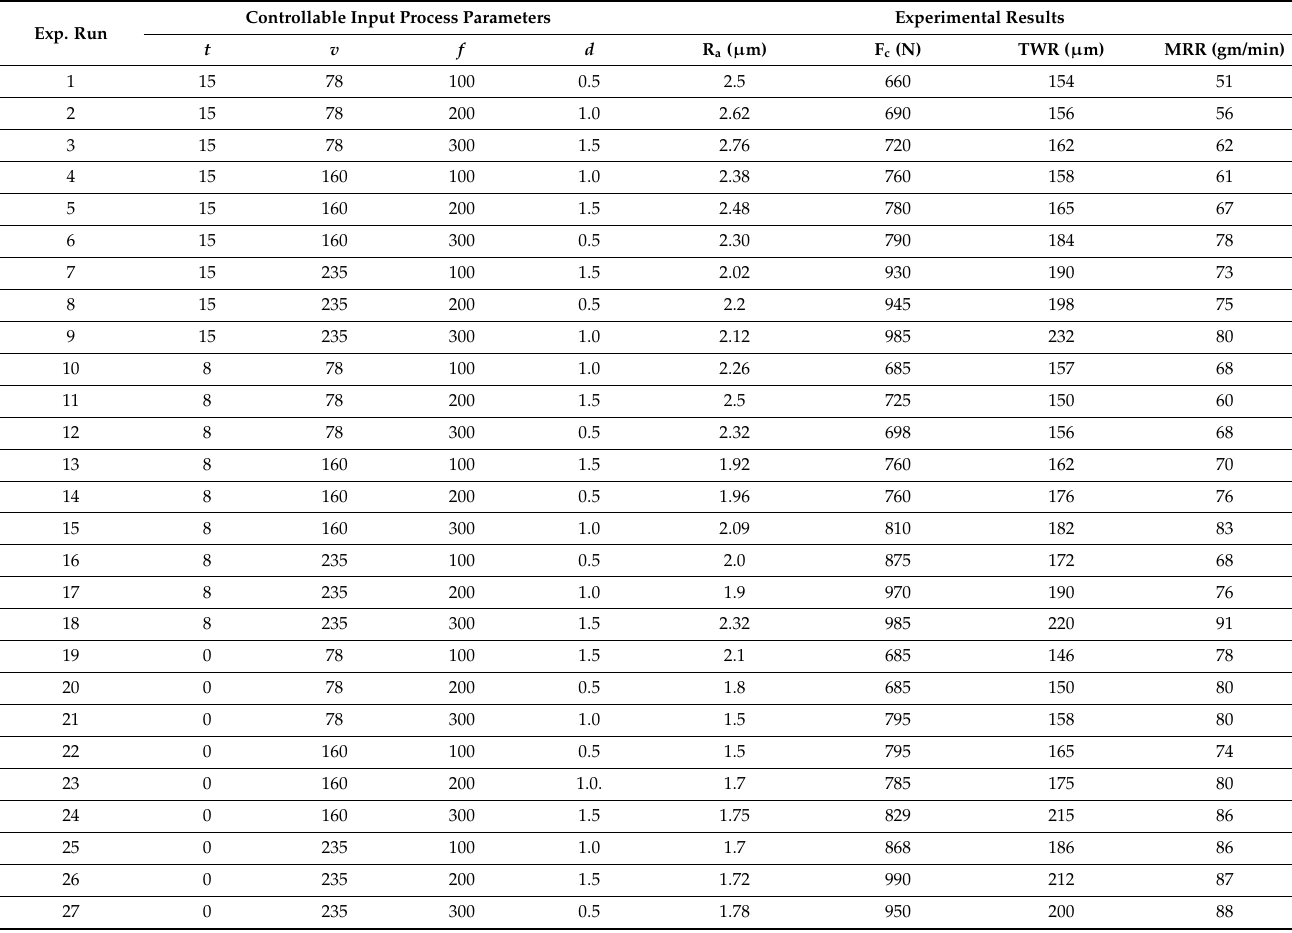
Table 3. Experimental results for the set of combinations of input process